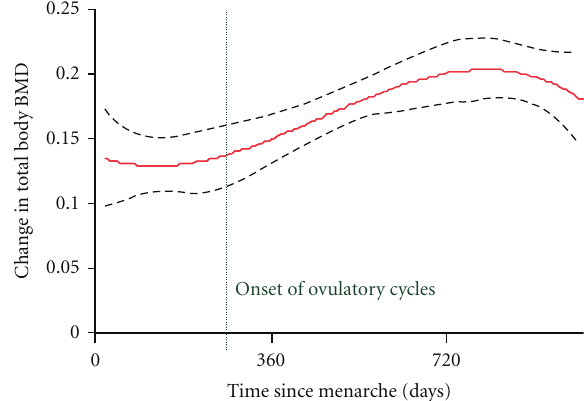
Figure 3: This graph shows the multivariable regression for the mean and the 95% confidence interval of the change in total body bone mineral density (BMD) over 3 years in relationship to time since menarche in 38 peripubertal girls studied prospectively [30]. The vertical line shows the earliest, in a subset of 13 girls who provided menstrual calendar data and salivary progesterone levels, that ovulation could be diagnosed [34]. Reprinted with permission of the authors. Society for Bone and Mineral Research permission